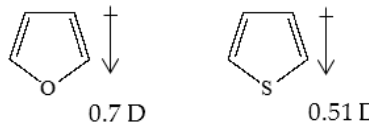
Figure 2. Dipole moment vector of furan and thiophene rings.